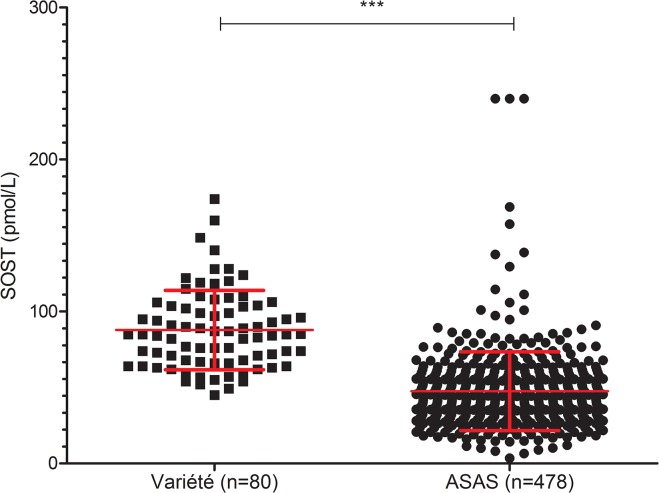
Serum sclerotin (SOST) level among patients with axial spondyloarthritis (SpA) and controls at baseline.Each point represents 1 patient. Data are mean ± SD. ***p<0.0001.